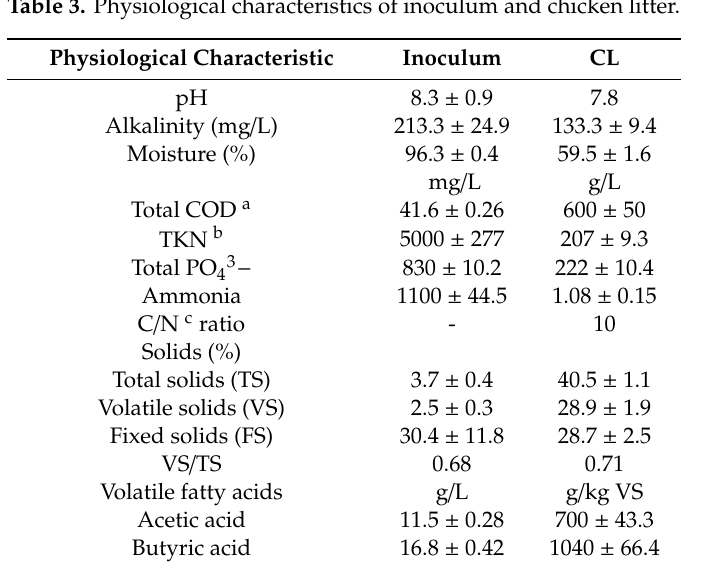
Table 3. Physiological characteristics of inoculum and chicken